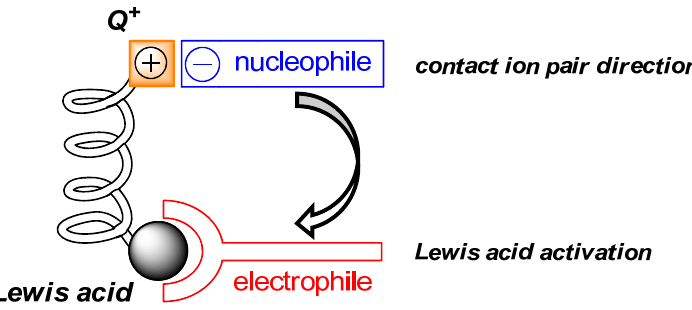
Figure 1. Cooperative action of a Lewis acid and an aprotic organic ion pair within a single catalyst entity: the Lewis-acid serves to activate an electrophile, whereas the in situ generated anionic nucleophile forms an ion pair with an aprotic organic cation (Q + ), which stabilizes and directs the nucleophile towards the electrophile [53,54].